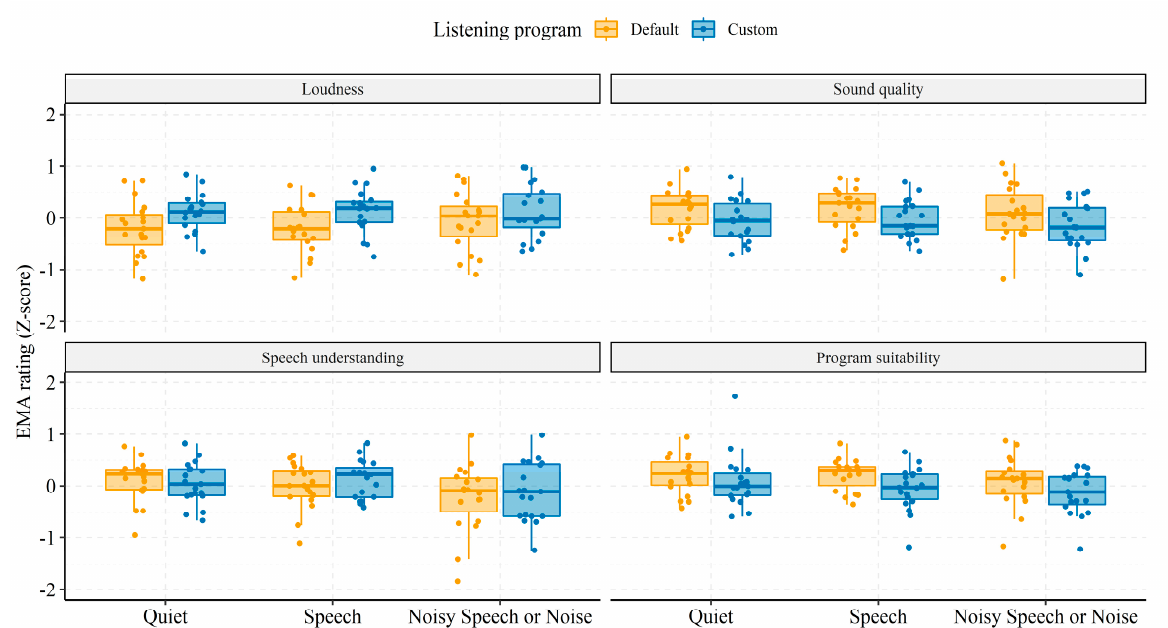
Figure 6. Boxplots of the average EMA rating for each question (panels) and listening program (colors) separated by soundscape (horizontal axis). EMA ratings were centered and scaled for each subject prior to averaging.